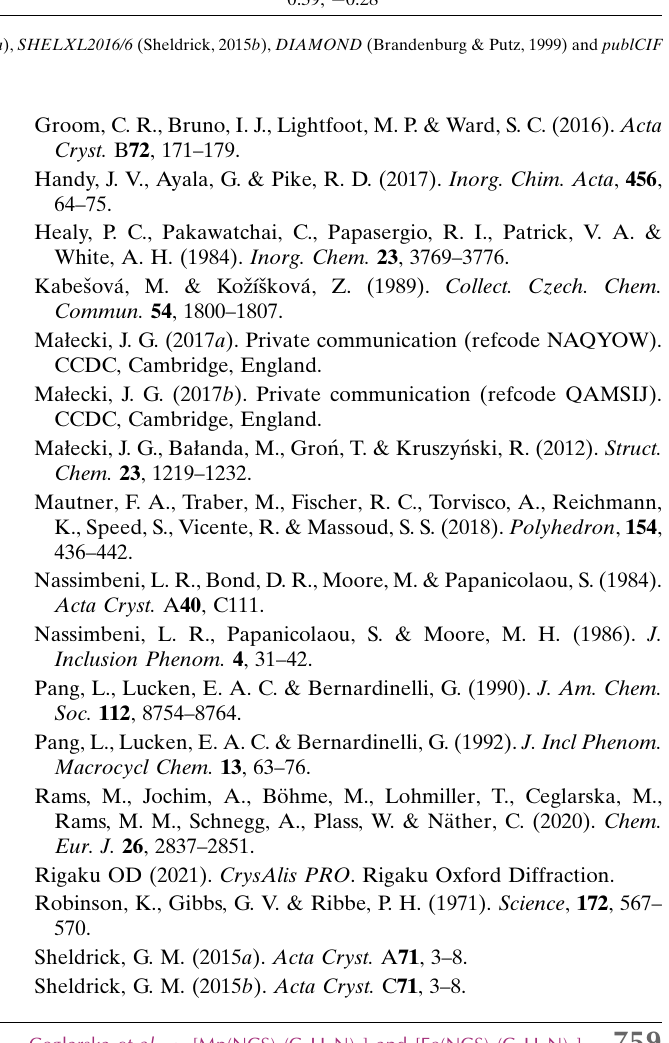
Crystal data Chemical